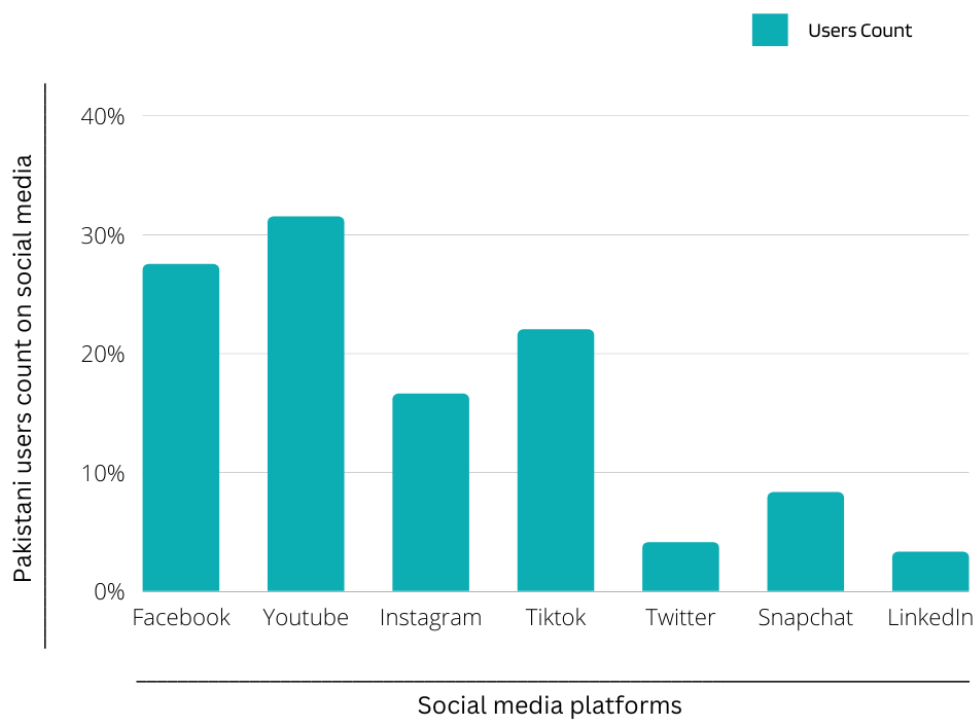
Figure 1. Active social media user stats of Pakistan based on each individual company’s ad reach in the start of